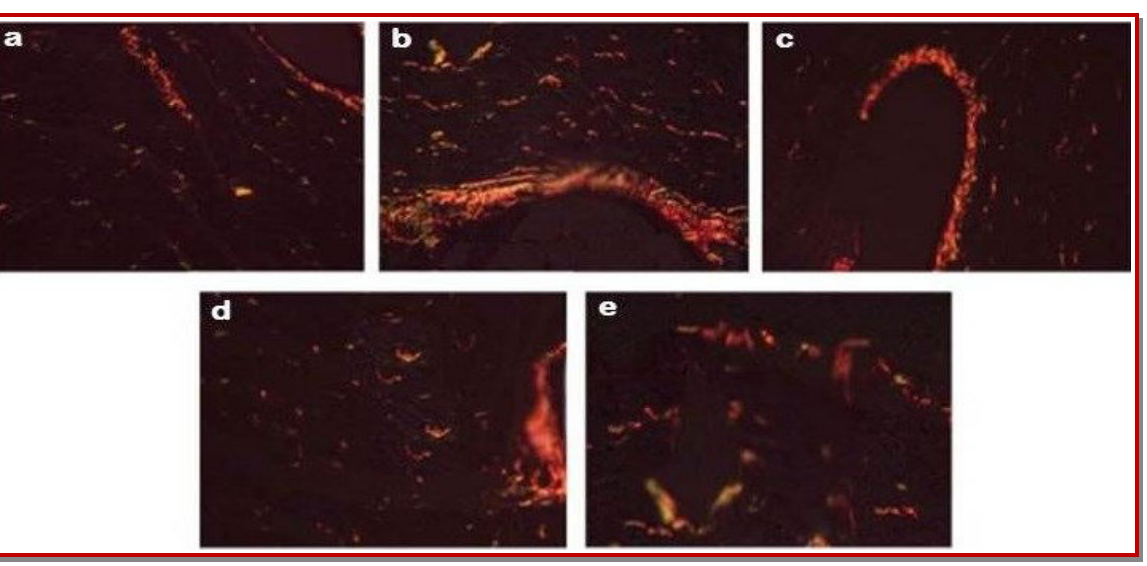
Figure 2: Sirius red staining showing the effect of paeonol on collagen deposition in cardiac tissues. The myocardium of the diabet- ic control rats presents with raised collagen accumulation (b) as compared against normal control rats (a) Paeonol treatment caused marked decreased collagen deposition in the myocardium as seen by sirius red staining (c-e); (a) Control; b) streptozotocin; c) 50 mg paeonol + streptozotocin; d) 100 mg paeonol + streptozotocin; e) 200 mg paeonol + streptozotocin)